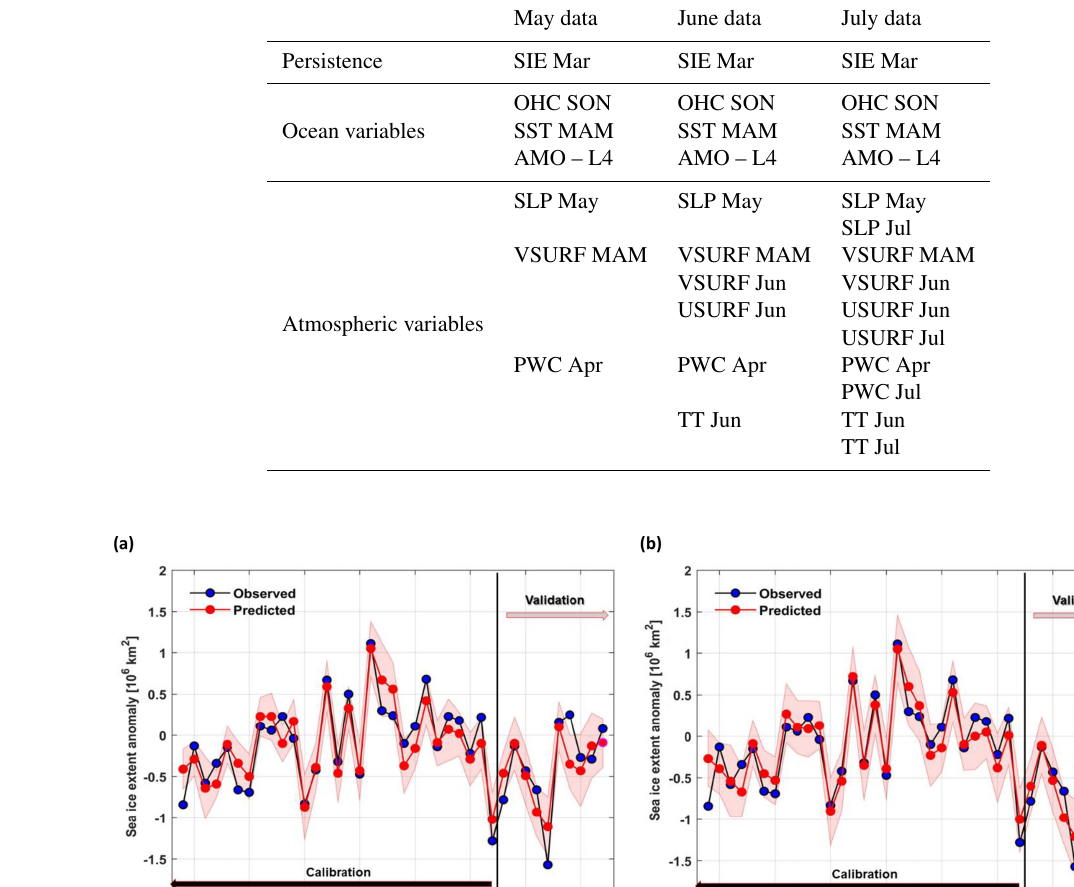
Earth Syst. Dynam., 10, 189–203,